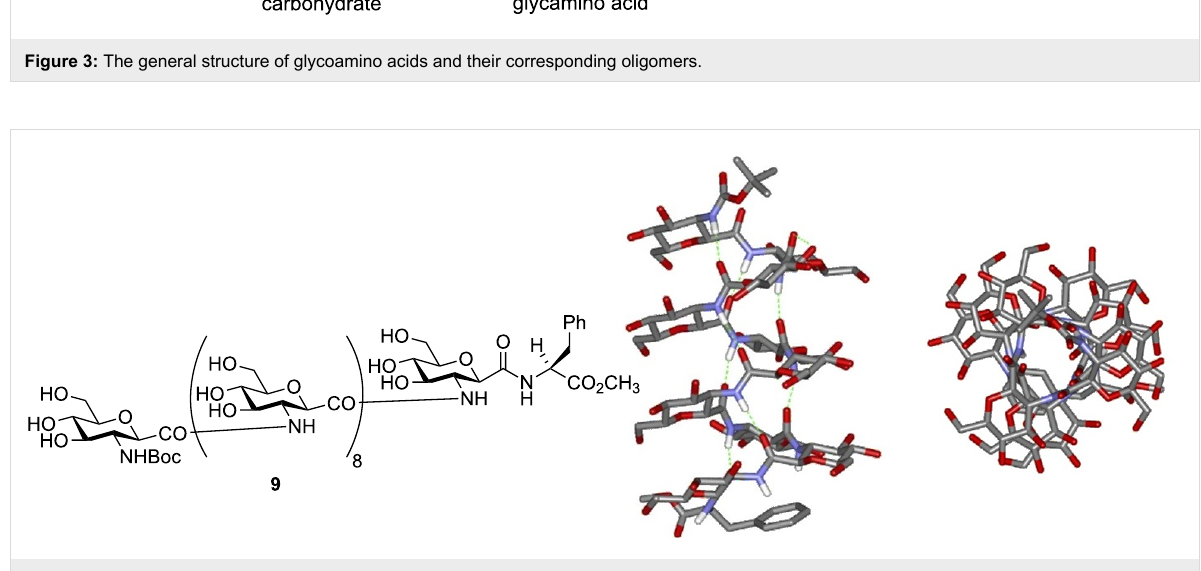
Figure 4: Conformational analysis of the β (1 → 2)-amide-linked glucooligomer 9 .